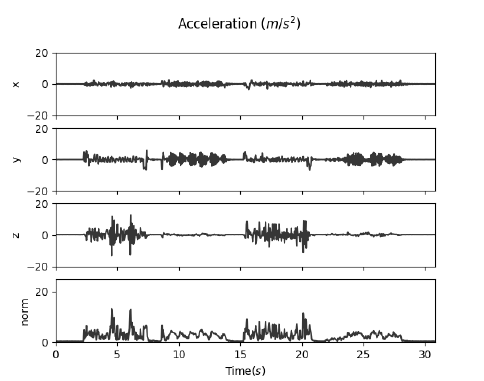
Figure 11. Vibration level of module (Normal, 50cm) Fig. 6 ~ Fig. 11 is a graph showing the vibration levels